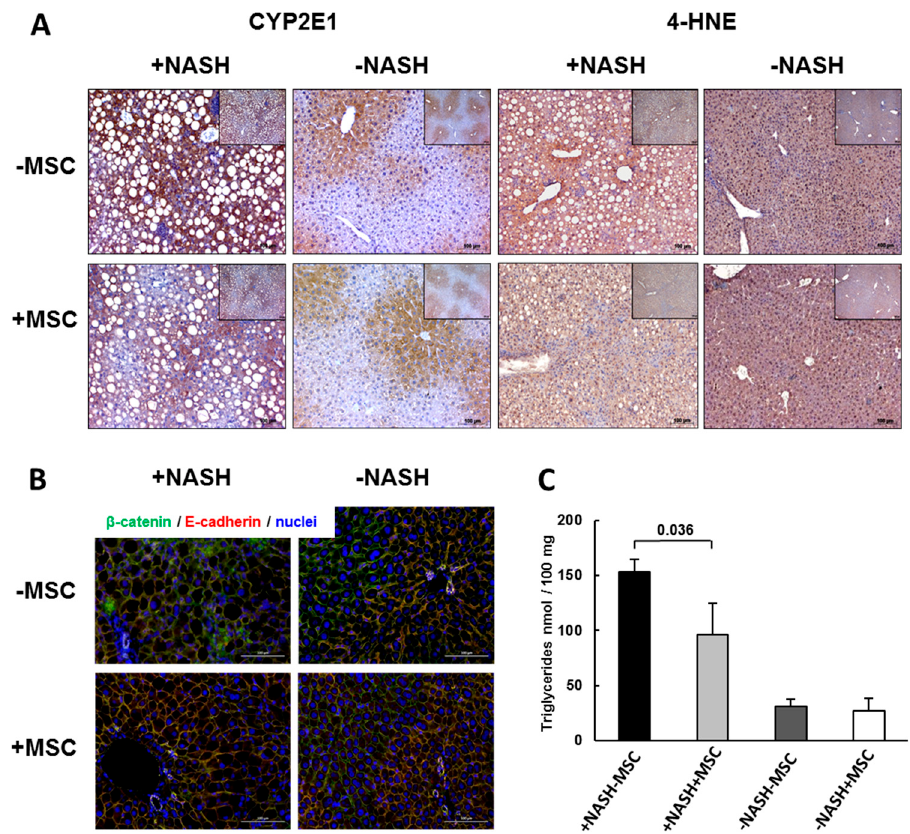
Figure 3. Liver tissue deterioration in MCD-treated mice and reversal by MSCs. ( A ) Immunohistochemical detection of Cyp2e1 and 4-HNE reveals an increase in perivenous localization in NASH livers, and restoration of zonation to nearly normal by MSC treatment. Pictures are representative for 3 different animals out of each group. White “holes” represent lipid droplets in NASH livers (original magnification 10×). The insets show lower magnifications for an overview impression (original magnification 5×). ( B ) Fluorescent immunohistochemical detection of adherens junction proteins β -catenin (green fluorescence) and E-cadherin (red, yellow in the overlay) indicates periportal zonation of E-cadherin, which is lost in NASH livers and restored by treatment with MSCs. Pictures are representative for 3 different animals out of each group. Scale bar 100 μ m. ( C ) Hepatic triglycerides in control (-NASH) and in MCD diet-fed (+NASH) mice either treated without (-MSC) or with (+MSC) human bone marrow-derived MSCs. Values are means ± SD from 5 animals in each group. The horizontal line indicates the significant difference between the +NASH-MSC and the +NASH+MSC group at p = 0.036. In addition to Johnson transformation, an ANOVA was performed p = 0.0001, post-hoc Dunett T p = 0.024.